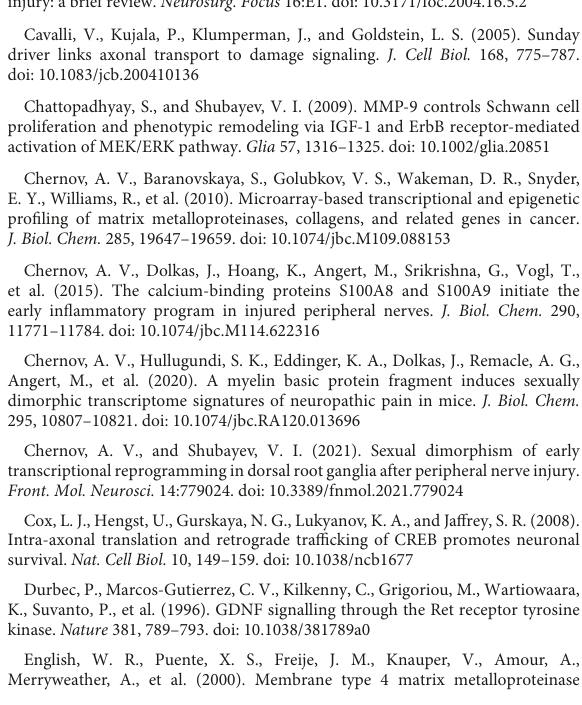
SUPPLEMENTARYTABLE2 Predicted upstream regulators. SUPPLEMENTARYTABLE3 Key resources